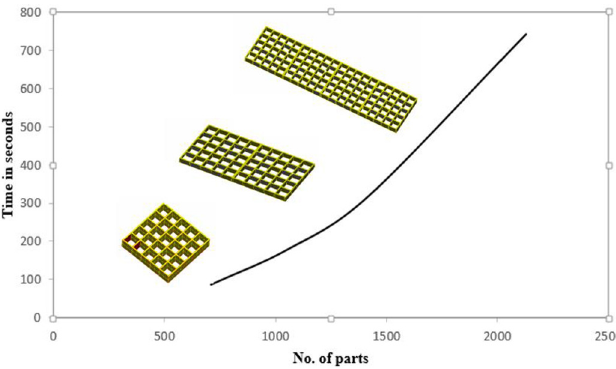
Fig. 2. Time study for conventional approach.